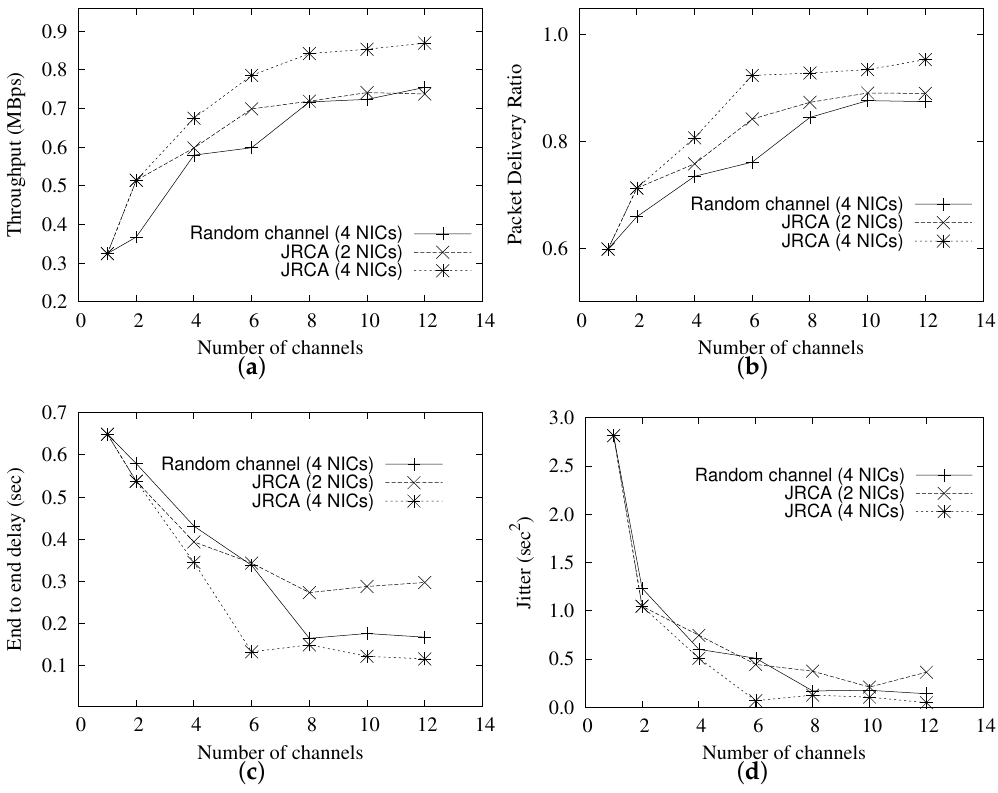
Figure 11. Comparison of ( a ) throughput ( b ) delivery ratio ( c ) delay ( d ) jitter with different number of channels for multi-channel WOBAN with multiple